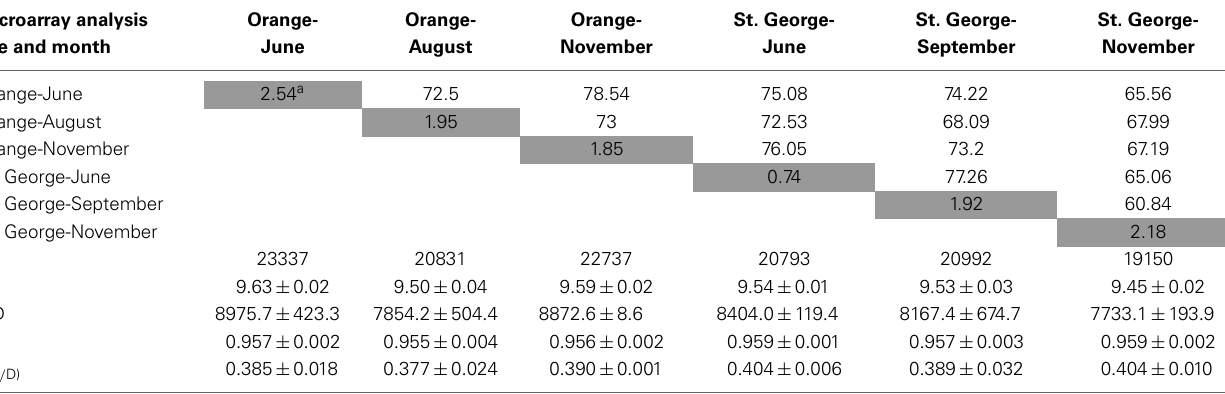
Table 1 | Functional gene variant diversity, similarity, and evenness and percentage of unique and shared genes among samples. Microarray